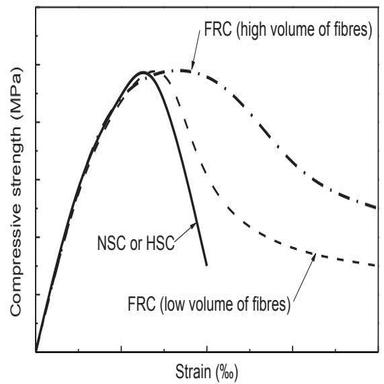
Behaviour of FRC in compression (after).